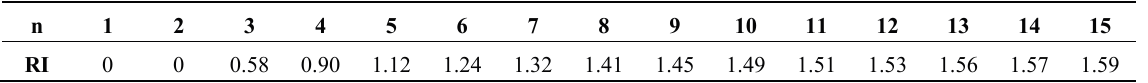
Table 2. Random Consistency Index (RI)